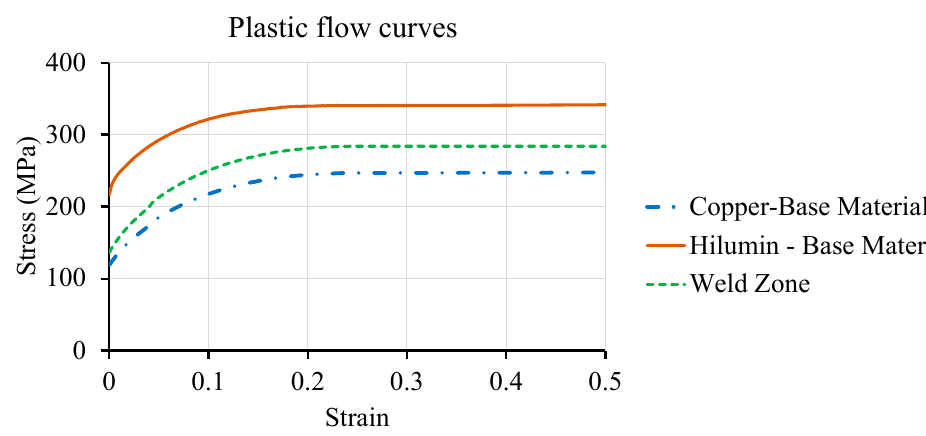
Figure 6. Laser micro-welded joint: ( a ) optical micrograph of the fusion zone, ( b ) top Cu surface weld bead, ( c ) bottom steel surface.